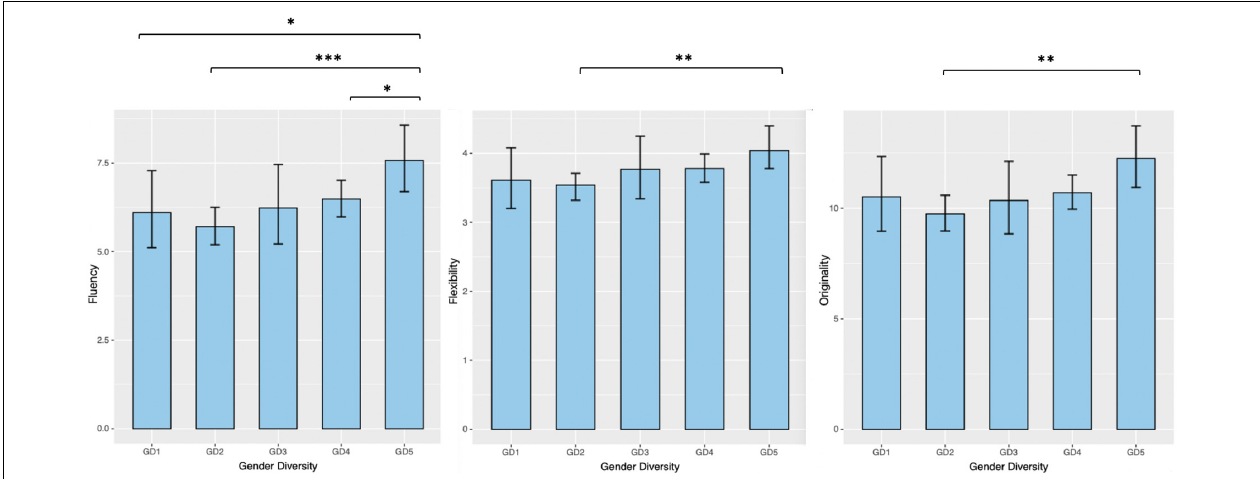
FIGURE 2 | Estimated marginal means (predicted values) of creative performance scores for each level of Gender Diversity. GD1: all-men groups; GD2: “solo” groups of one-woman and two- or three-men; GD3: groups of two men and two women; GD4: “solo” groups of one-man and of two- or three-women; GD5: all-women groups. Intervals are 95% confidence intervals for the predicted values adjusted for task and creative cognition. Predictions are on the population-level and do not account for the random effect variances. * p < 0.05, ** p < 0.01, *** p <